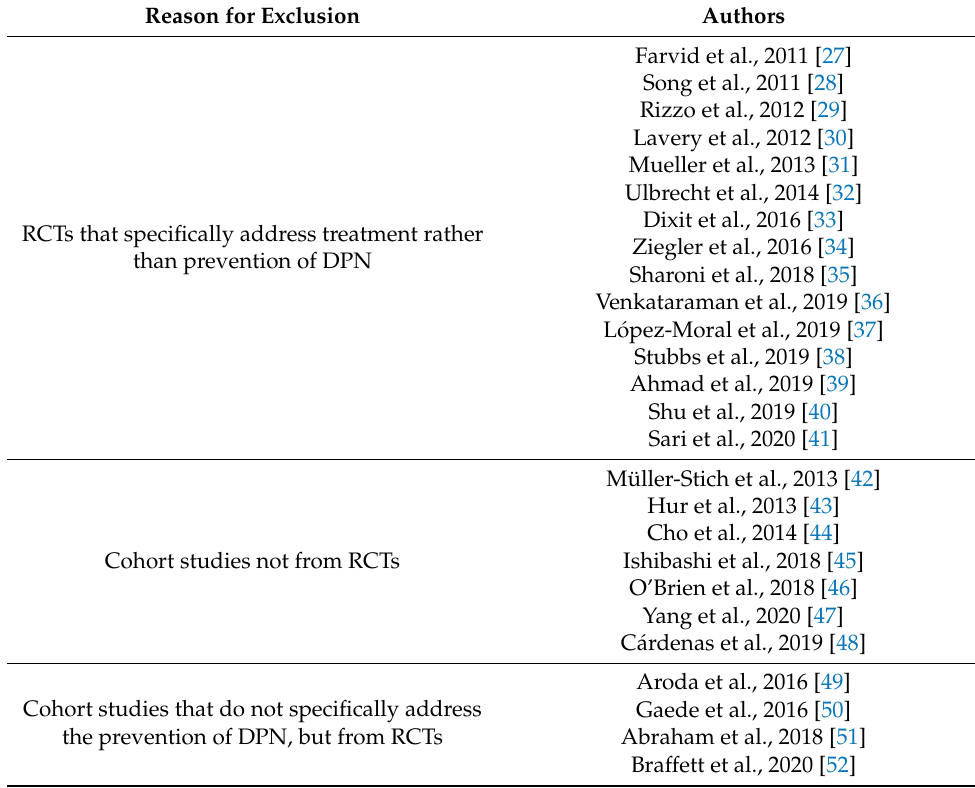
Figure 1. PRISMA flow diagram adapted with permission from the PRISMA group, 2020. Table 1. Potential studies excluded.